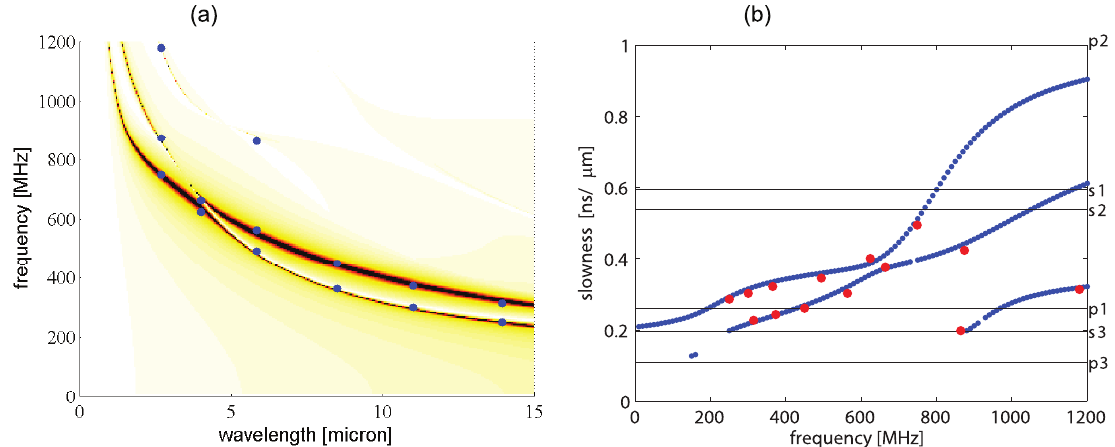
Figure 8. Experimental points (bold dots), | K 33 | level-line image ( a ) and slowness dispersion curves ( b ); straight-NW sample Figure 1. Table 2. Effective parameters of the HSQ-NW composition obtained for the samples Figure 1